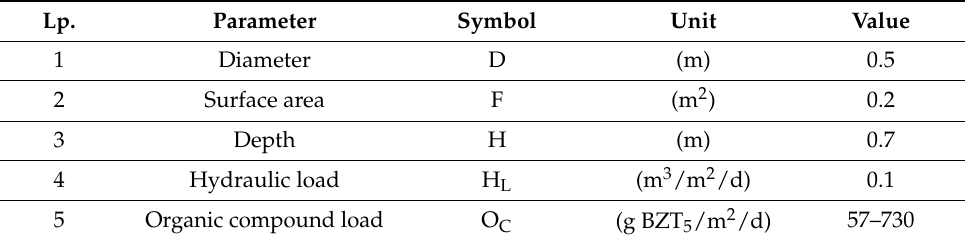
Table 2. Parameters of constructed wetland bed of the research facility.